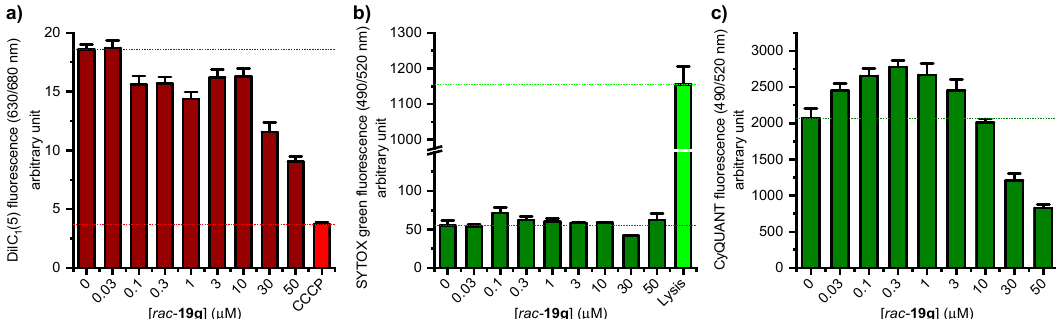
Figure 2. Effect of rac- 19g on A2780 ovarian carcinoma cells. Cells were incubated with the indicated concentration of rac- 19g and assayed to investigate ( a ) mitochondrial membrane potential using DilC 1 (5) staining, ( b ) plasma membrane integrity using SYTOX Green labeling, and ( c ) total DNA content using CyQUANT assay as described in the materials and methods. As positive control, CCCP and lysis were used to disrupt mitochondrial membrane potential and plasma membrane integrity, respectively. Data are presented as mean ± SEM, N = 4 at each data point presented.